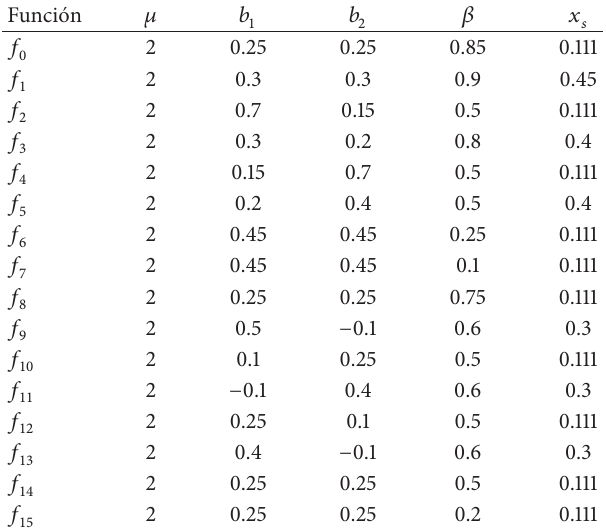
Table 4: Parameter’s values for generating 16 logic functions.